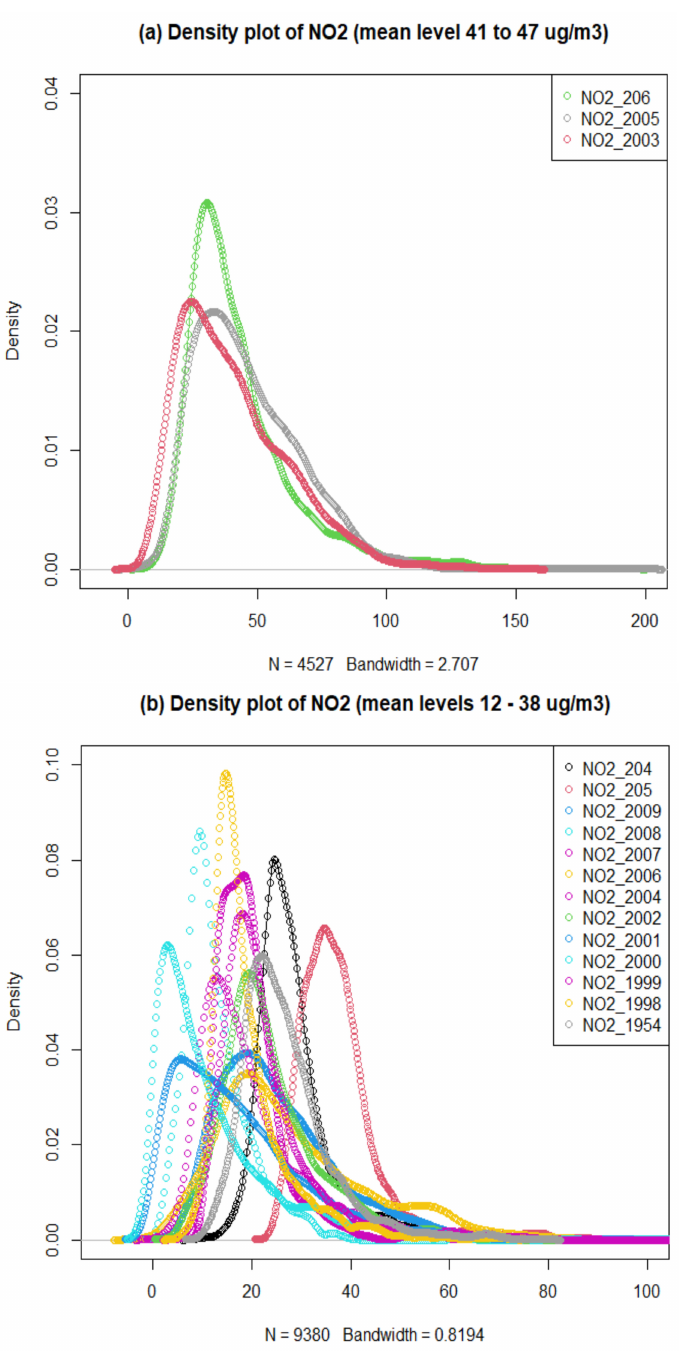
Figure 7. Density plots of hourly NO 2 concentrations ( µ g/m 3 ) measured by AQMesh pods from August 2019 to September 2020 in